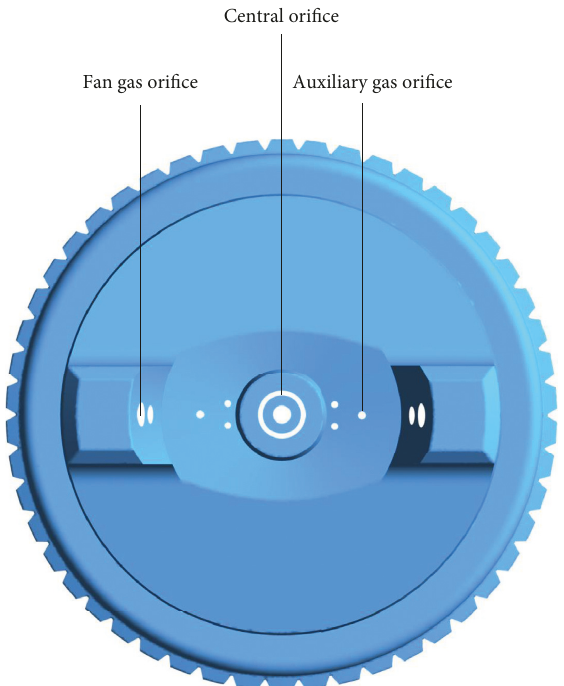
Figure 1: Multiorifice nozzle structure.